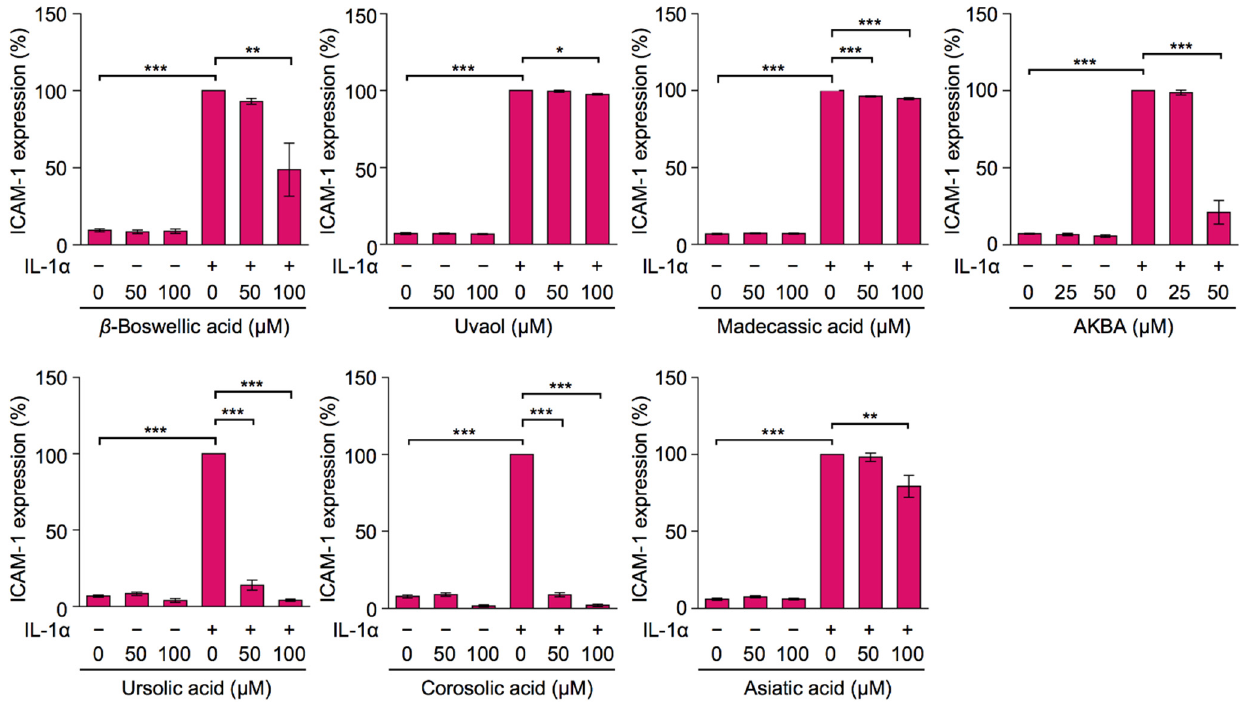
Figure 3. Effects of ursane-type pentacyclic triterpenoids on cell-surface ICAM-1 expression. A549 cells were preincubated with serial dilutions of triterpenoids for 1 h, and then incubated with (+) or without ( − ) IL-1 α (0.25 ng/mL) for 6 h in the presence of triterpenoids at the indicated concentrations. ICAM-1 expression was evaluated by cell-ELISA. ICAM-1 expression (%) is shown as the mean ± S.E. of three independent experiments. * p < 0.05, ** p < 0.01, and *** p < 0.001.